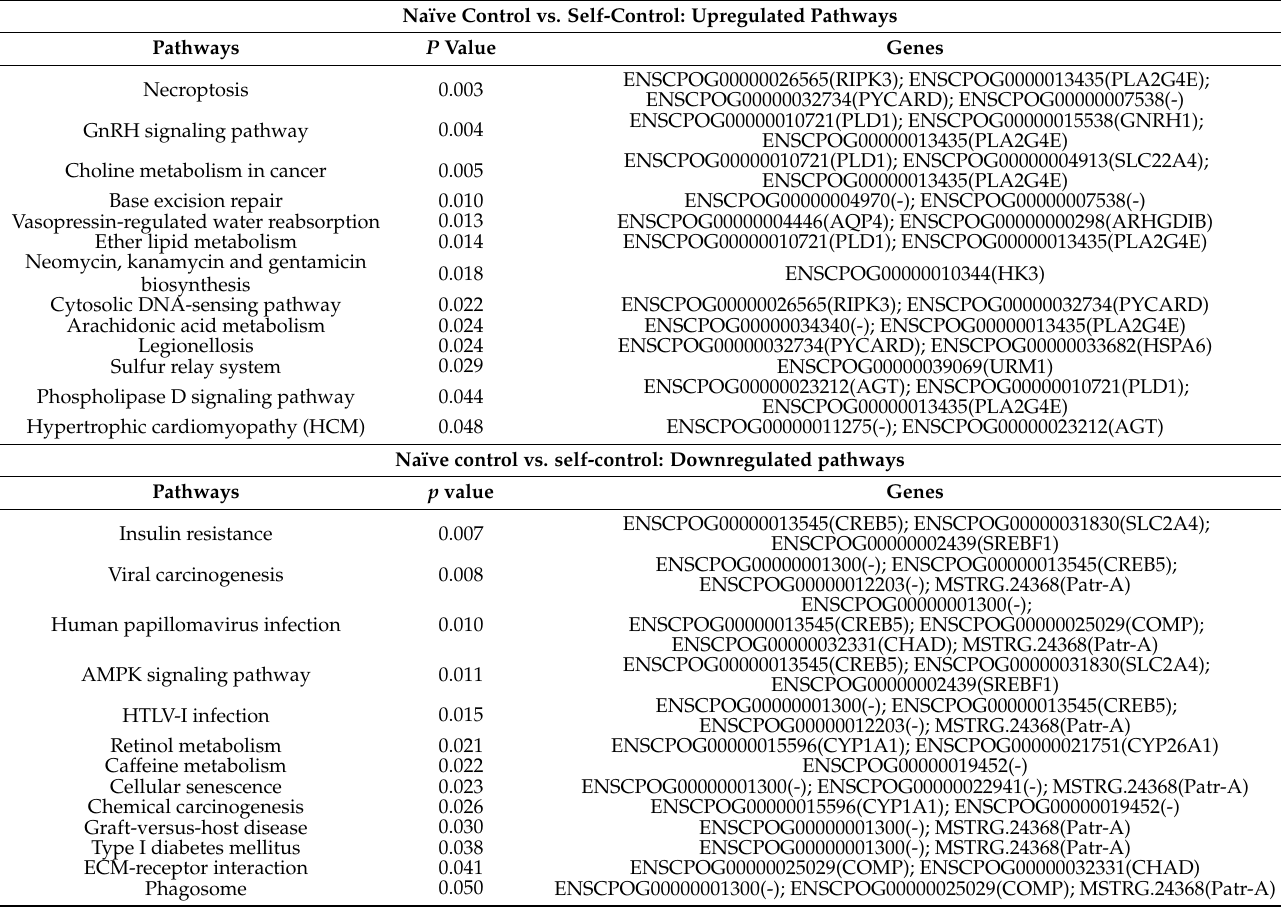
Table A6. KEGG enriched pathways by DEGs between naïve control vs. self-control.